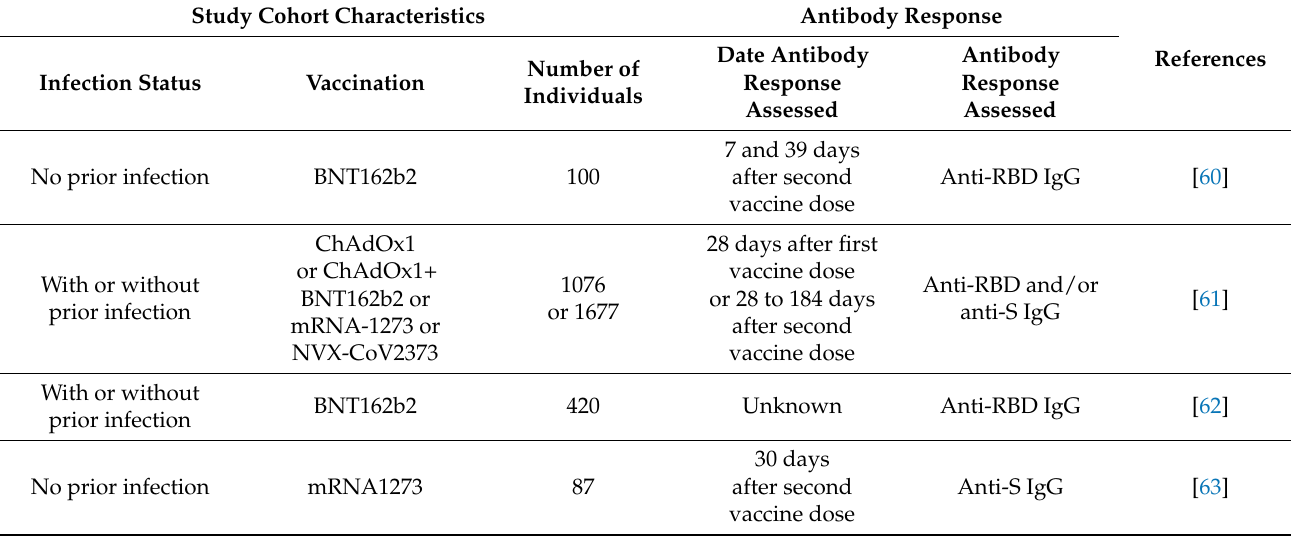
Table 1. Studies on HLA variants and association with antibody